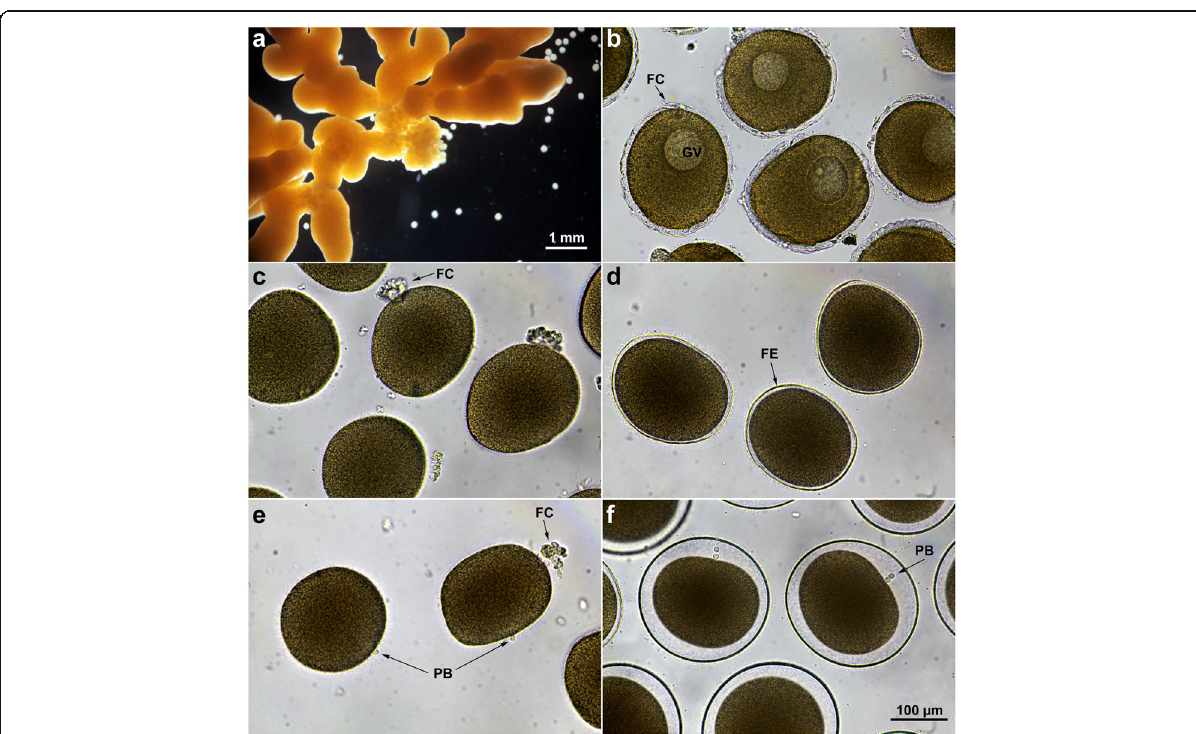
Fig. 1 Light microscopy images of the ovary, and of living oocytes from the starfish Patiria pectinifera before and after 1-methyladenine (1-MA) treatment. a A ripe ovary dissected from P. pectinifera, containing numerous fully grown immature oocytes. b Immature oocytes isolated from the ovary are surrounded by a layer of follicle cells (FC); the large nucleus termed germinal vesicle (GV) is visible in the cytoplasm. c Maturing oocytes treated with 1-MA for 50 min; at this point in maturation, the FC are clustered to one side of the oocytes. This is the optimal time at which eggs can be successfully fertilized (i.e., monospermic fertilization). d Fertilized eggs 3 min after insemination are surrounded by the fertilization envelope (FE) as a result of the cortical granules exocytosis. e In the absence of fertilization, the first polar body (PB) forms 65 to 75 min after 1-MA application. f Extrusion of the second polar body 105 to 115 min after fertilization of eggs matured for 50 min with 1-MA